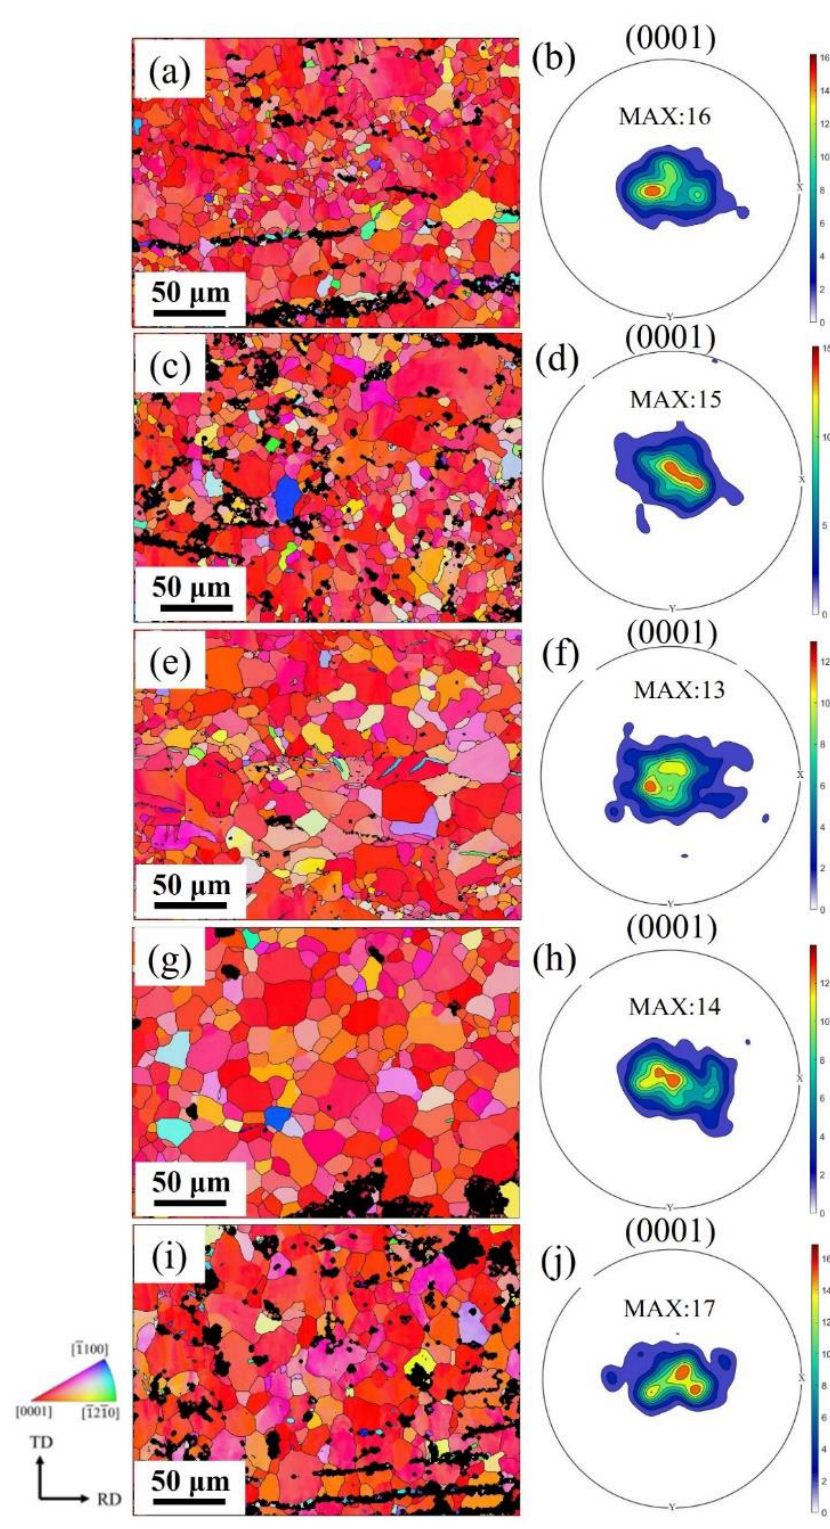
Figure 4. The IPF and the corresponding {0001} pole figurers of the rolled sheets with different Y